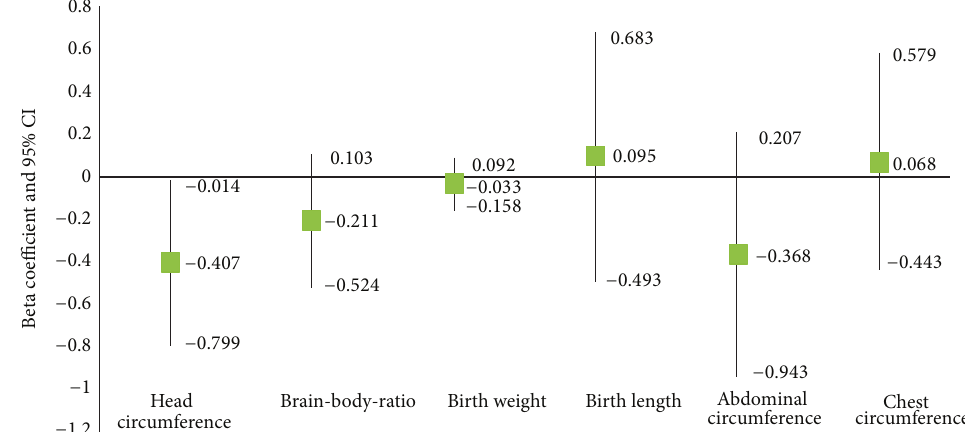
Figure 2: Unadjusted analysis of newborn brain and body growth variables at delivery (brain weight omitted from graph due to scaling differences( 𝛽 = −10.307 (95%CI − 20.130– − 0.483)))(linearregressionbetacoefficientand95%confidenceinterval(CI)),TampaBay,Florida,